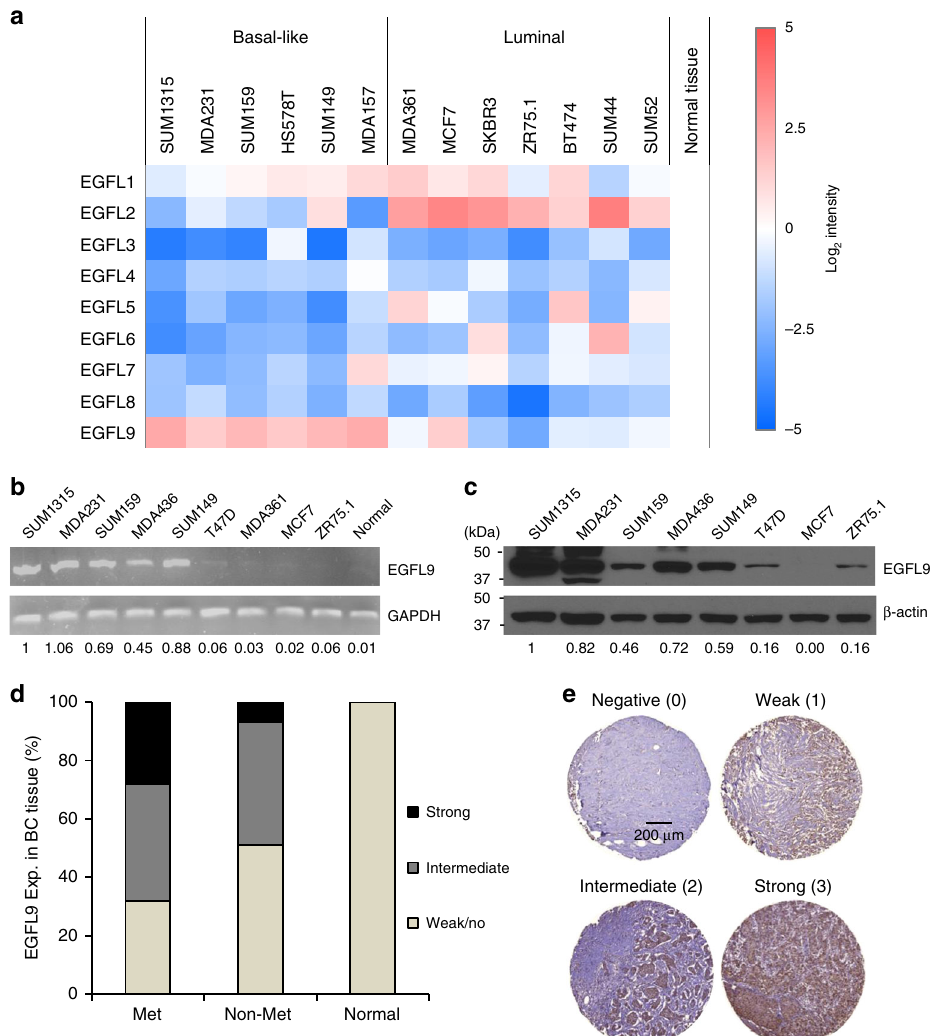
Fig. 1 Expression of EGFL9 in breast cancer. a Heat map showing expression levels of the EGF-like family genes in a set of breast cancer cell lines cells. Data are normalized to GAPDH expression. Log2 intensity scale is shown on the right. b Expression of EGFL9 at the RNA level in human breast cancer cell lines. The top panel shows EGFL9 RNA expression examined by RT-PCR. The bottom digits show quantitation of the RT-PCR results. GAPDH was used as a loading control for RNA. c Expression of EGFL9 at the protein level in human breast cancer cell lines. The top panel shows the EGFL9 protein expression level examined by western blotting. The bottom digits show the quantitation of the EGFL9 protein expression level examined by western blot analysis. β - Actin was used as a protein loading control. d Summary of the EGFL9 IHC results in human breast tumor tissue microarray. e Expression of EGFL9 protein in human breast tumors. The panels show representative fi gures of the immunohistochemistry assay. 0 is no staining, 1 is an example of weak staining, 2 is intermediate staining, 3 is strong staining. Scale bar: 200 µ mesenchymal to epithelial transition (MET) in either the 4T1 or (Fig. 3a). Metastasis was quanti fi ed based on H&E staining of SUM159 cell models with EGFL9 knockdown at both the lung sections. A signi fi cant increase in the number of micro- molecular and cellular level (data not shown). These data suggest scopically visible pulmonary metastases was observed upon that ectopic expression of EGFL9 alone is not suf fi cient to trigger ectopic expression of EGFL9 ( P = 0.001) (Fig. 3b). Moreover, a a complete EMT. larger metastatic tumor area (tumor area/total lung area) was observed in the EGFL9 overexpression cells (3 – 15%) compared to the control (0 – 2%) implanted group ( P = 0.001) (Fig. 3c, d). To validate the role of EGFL9 in tumor growth and distant metastasis, 4T1 cells with either EGFL9 knockdown or a non- target control were injected into the fat pads of BALB/C mice. Mice were sacri fi ced after 30 days of transplantation when the control group of mice reached the humane endpoint. Immedi- ately before sacri fi ce, tumor size and metastatic progression were analyzed by magnetic resonance imaging (MRI). We found that tumor size was similar between these two groups (Fig. 4a, c).